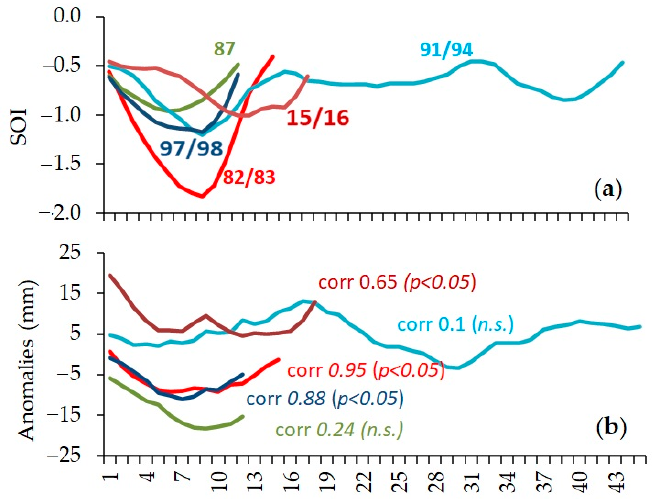
Figure 11. ( a ) Major El Niño events starting from the first month (horizontal axis) when the SOI was below − 0.5 along with the ( b ) precipitation anomalies during the concurrent months ( b ).